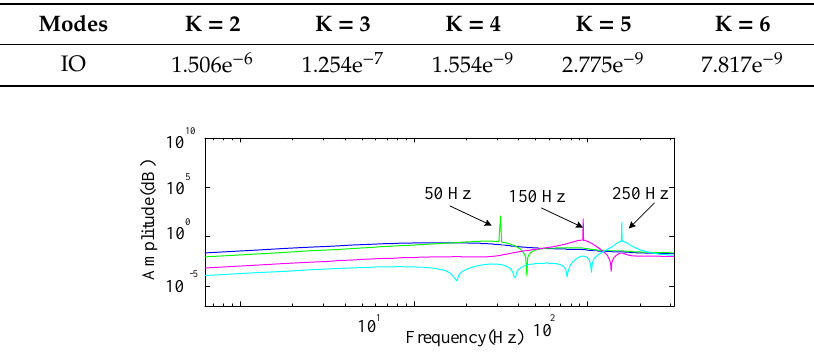
Table 2. IO of VMD-HT algorithm decomposition under different K.